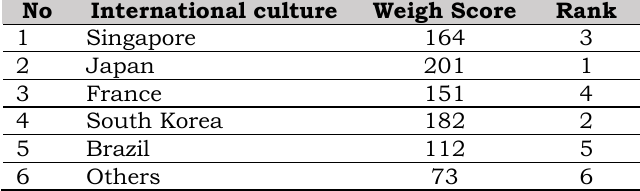
Table 2. Students’ preference for international culture